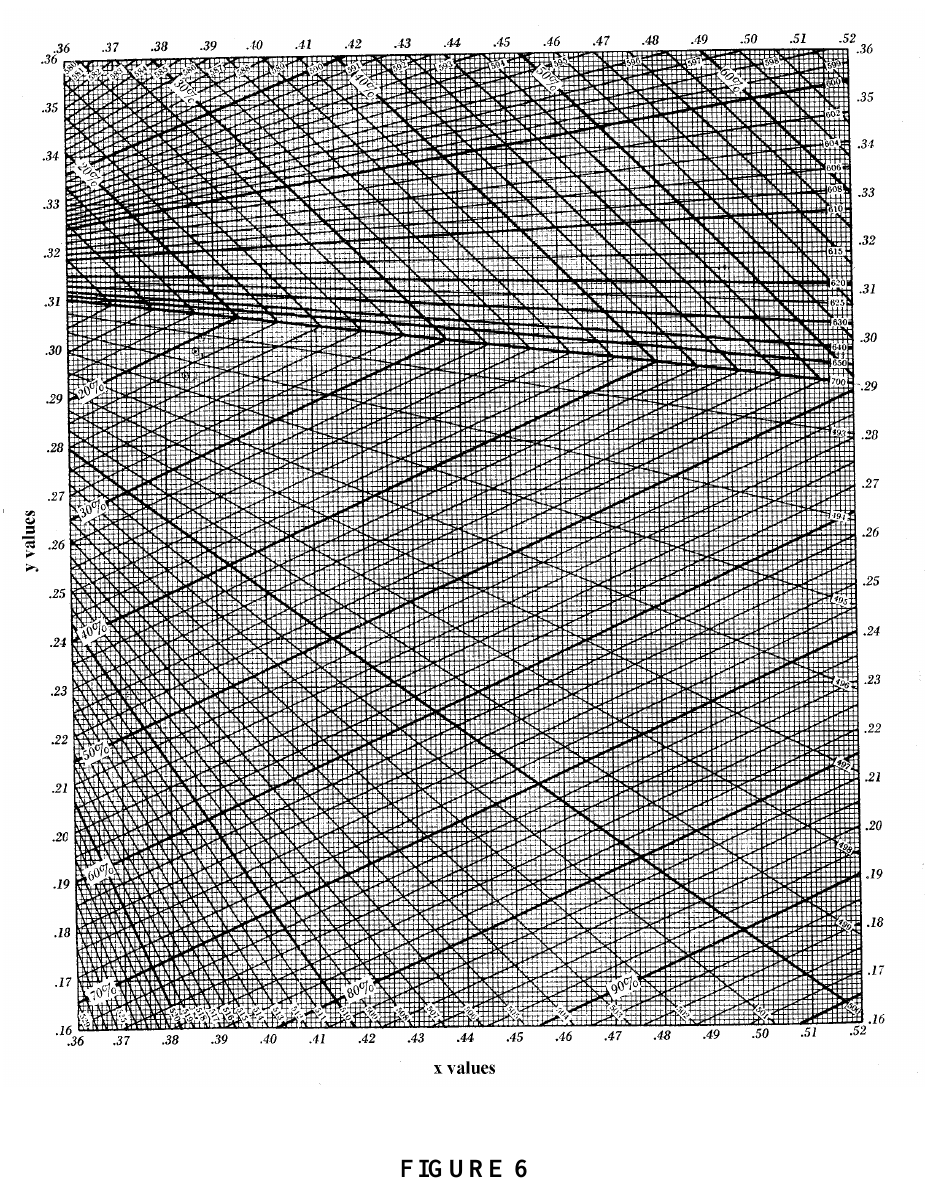
Chromaticity diagram for brick red wines and purple red